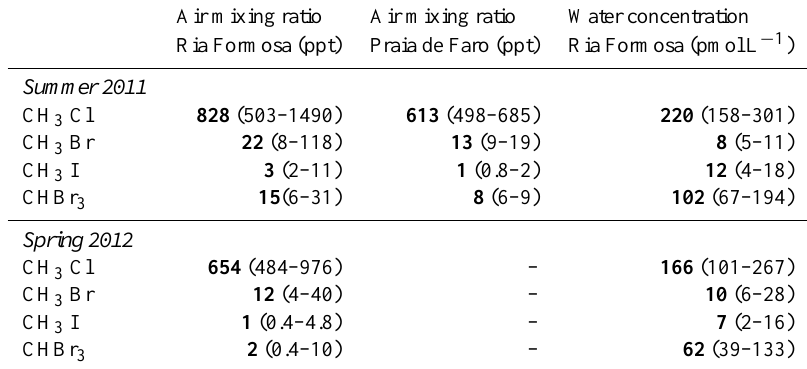
Table 1. Summary of air mixing ratios and water concentrations of halocarbons in the Ria Formosa and at the background site (Praia de Faro) for the sampling campaigns in summer 2011 and spring 2012. Values are given as means (bold) and ranges (in parentheses). Samples from the Ria Formosa are data from the inlet of the flux chambers with a sampling height of 1m above ground (summer: n = 36; Praia de Faro: n = 5; spring n = 47). Given water concentrations refer to n = 8 (summer) and n = 10 (spring).